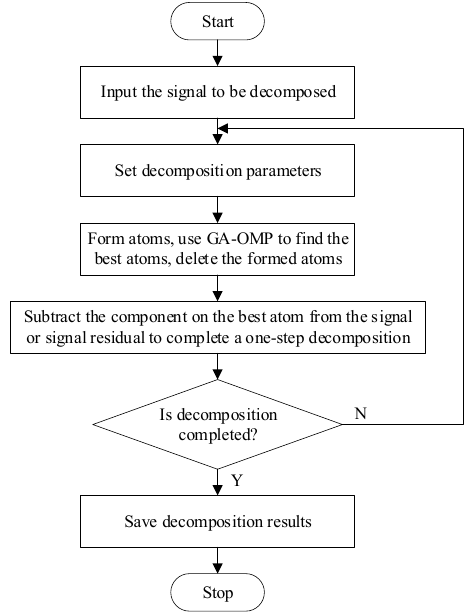
Figure 5. Flow chart of the GA–OMP algorithm.